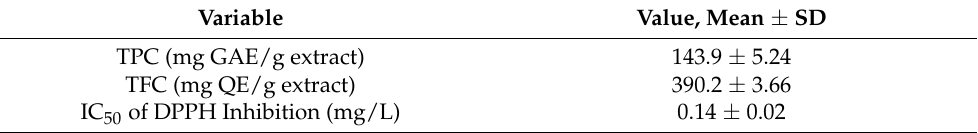
Table 2. Antioxidant activity and capacity of ethanolic extract from L. acidissima fruits.